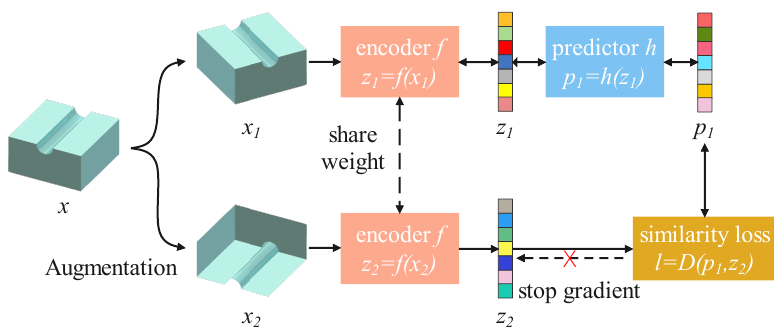
Figure 2. The architecture of the self-supervised method.